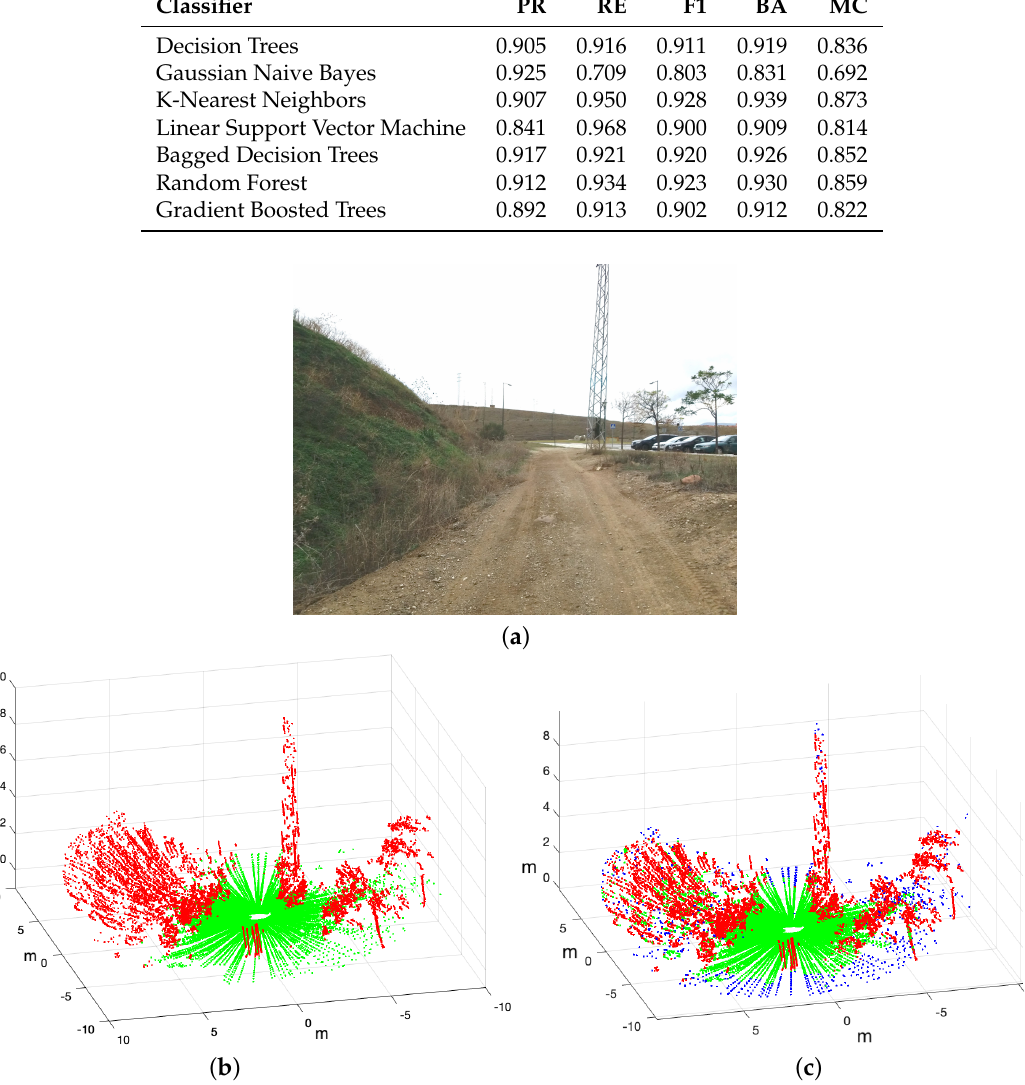
Figure 10. A photograph of a rural path ( a ) and a real 3D point cloud from Andabata manually-tagged ( b ) and classified with RF ( c